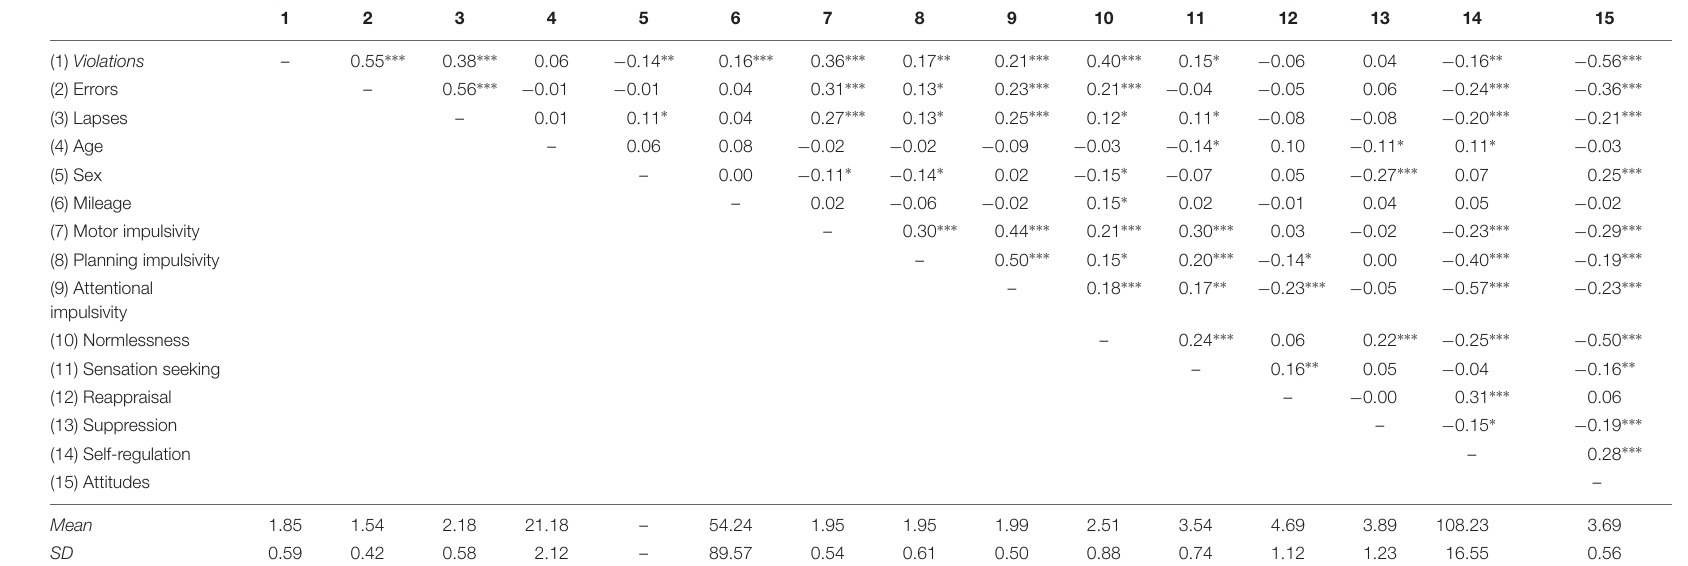
TABLE 1 | Descriptive statistics and inter-correlations among the study